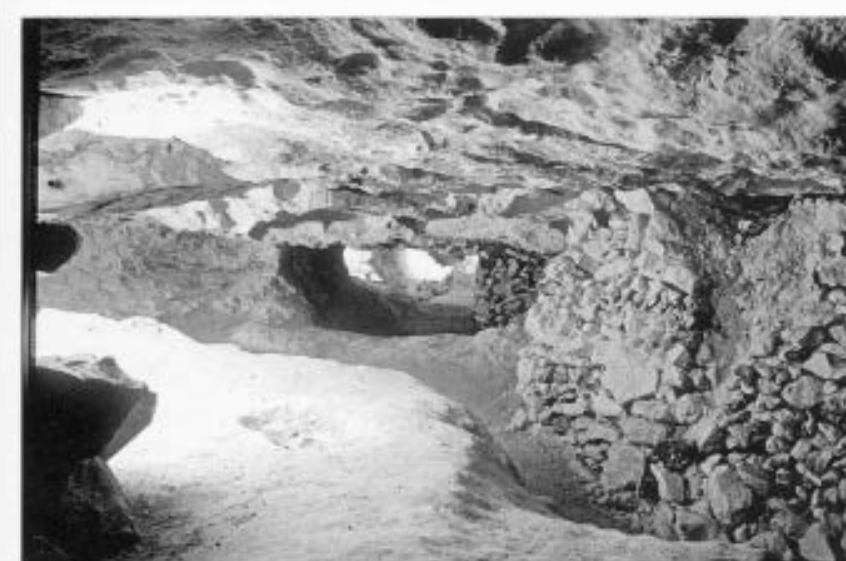
Figure 6 Neolithic flint mines at Spiennes, near Mons, Belgium.